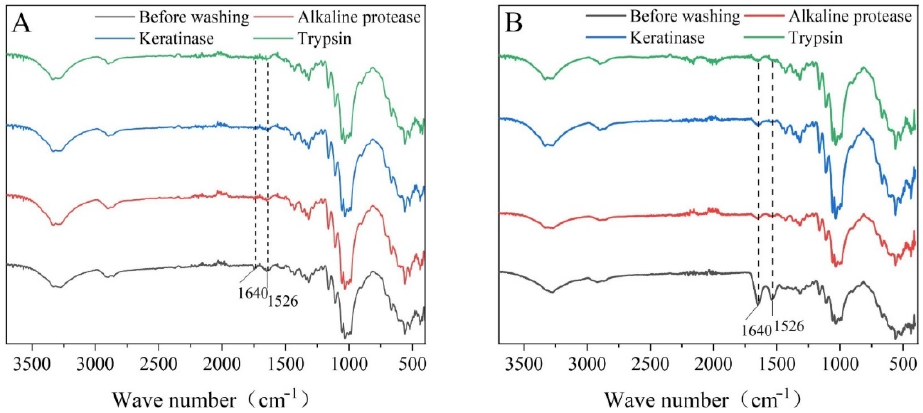
Figure 2. Infrared spectra of dirty cloth before and after washing with different proteases. ( A ) Pro- tein-fouling cloth. ( B ) Blooddirty cloth.